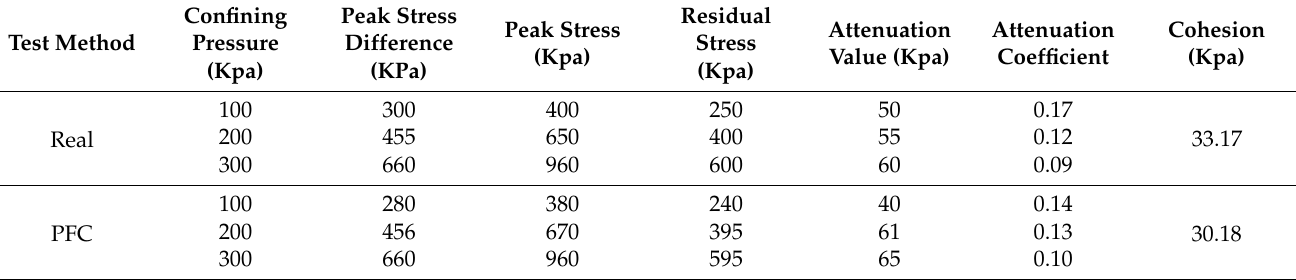
Table 2. Comparison of triaxial macroscopic mechanical